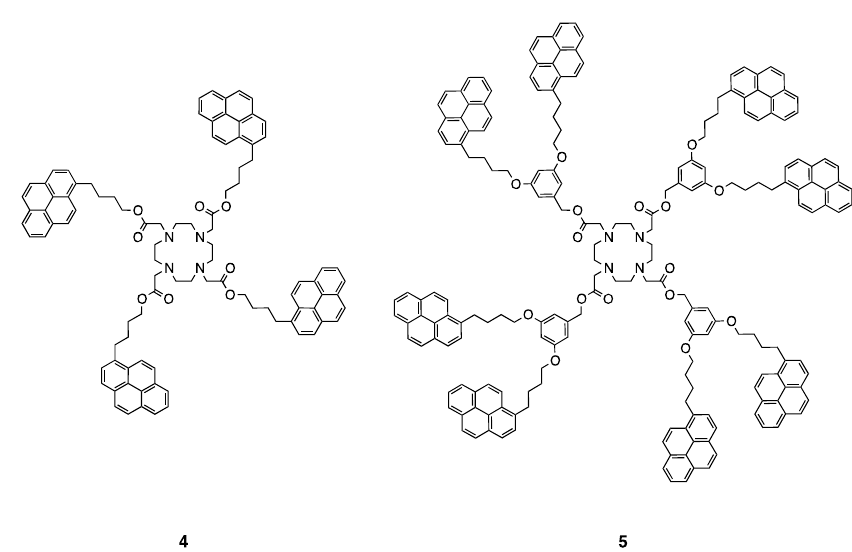
Figure 16. Structures of the DOTA-based ligands containing four and eight pyrene units [127].